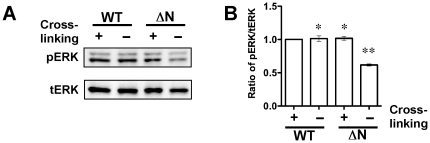
Effect of ß4 integrin Ab-mediated α6ß4 integrin clustering on phosphorylation of ERK.(A) WT and ΔN keratinocytes were incubated on ice for 30 min in the presence of rat anti-ß4 integrin mAb. The cells were washed and then incubated in the presence (cross-linking, +) or absence (cross-linking, –) of a rabbit anti-rat secondary Ab at 37°C for 10 min. Following incubation, the cells were analyzed for the phosphorylation of ERK by immunoblotting. (B) Results of the densitometric analysis are shown as the integrated density of the ratio of phospho-ERK (pERK) to total ERK (tERK) bands, and the ratio in WT keratinocytes with cross-linking (WT, +) was 1.0. *P>0.05, **p<0.001 (one-way ANOVA, Bonferroni post test) vs. WT with cross-linking. All blots are representative of at least three independent experiments.